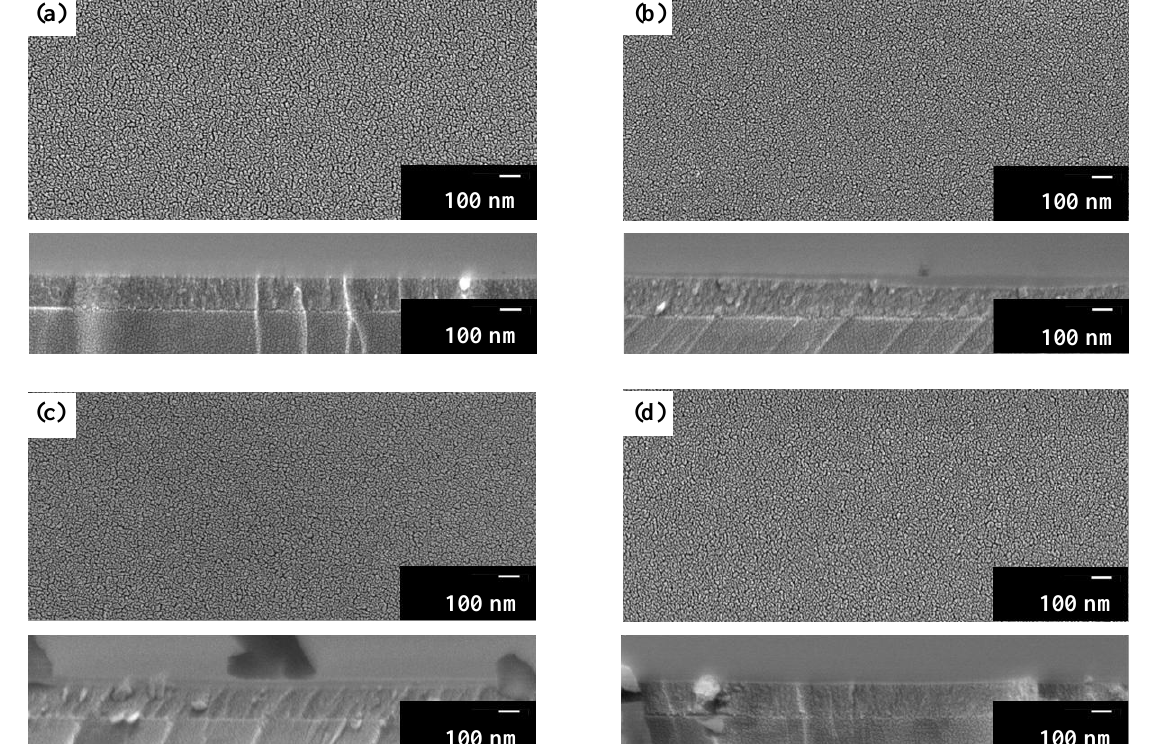
Figure 6. Scanning electron microscope (SEM) images of top and cross-sectional views of ( a ) F 2 , ( b ) F 4 , ( c ) F 8 , and ( d ) F 16 . The thicknesses of F 2 , F 4 , F 8 , and F 16 are approximately 170, 170, 160, and 160 nm,